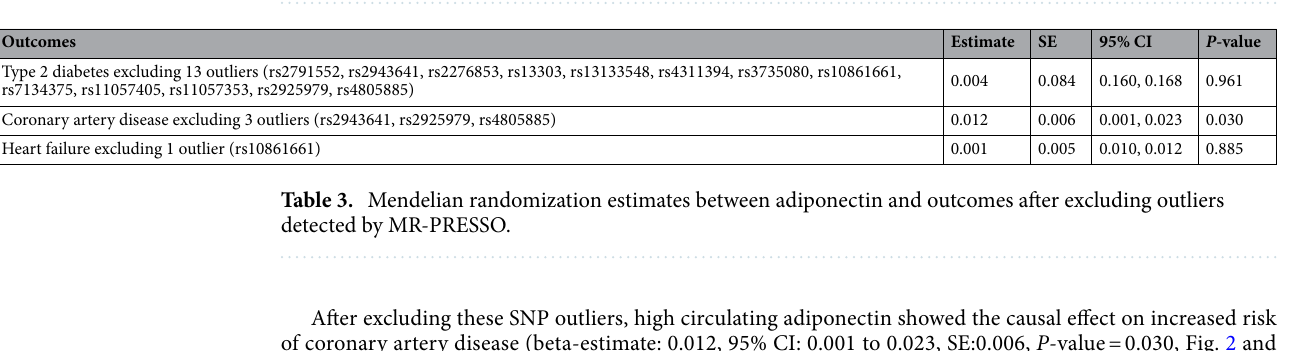
Figure 7. Beta (95% CIs) for causal influence of circulating adiponectin on osteoporotic fracture through multiple analyses.